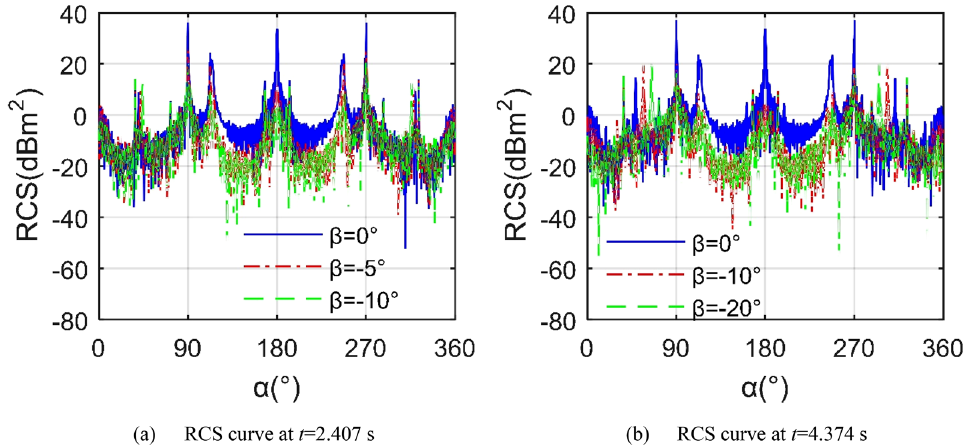
Figure 14. RCS of the aircraft in Z3 mode, f RH = 6 GHz, ω m1 = ω m2 = 0.1963 rad/s.